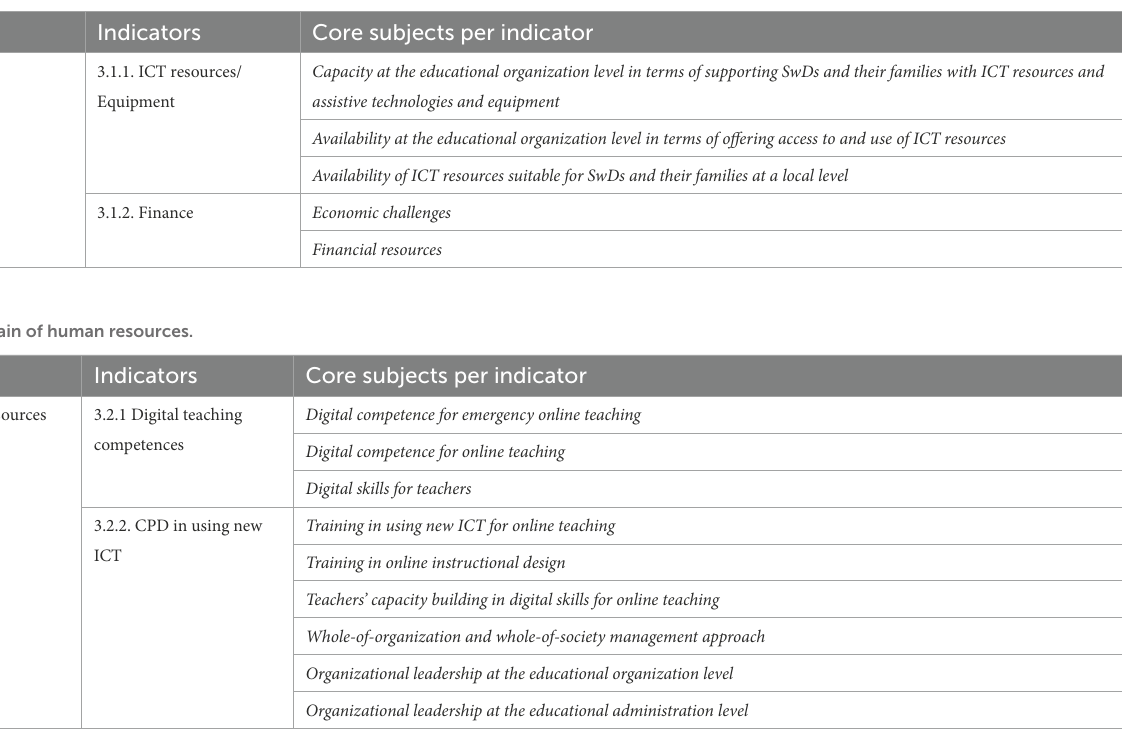
TABLE 2 Domain of resources.